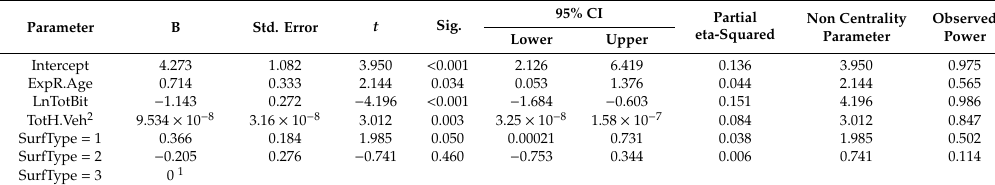
Table 13. Parameter estimates for the model of Equation (15).